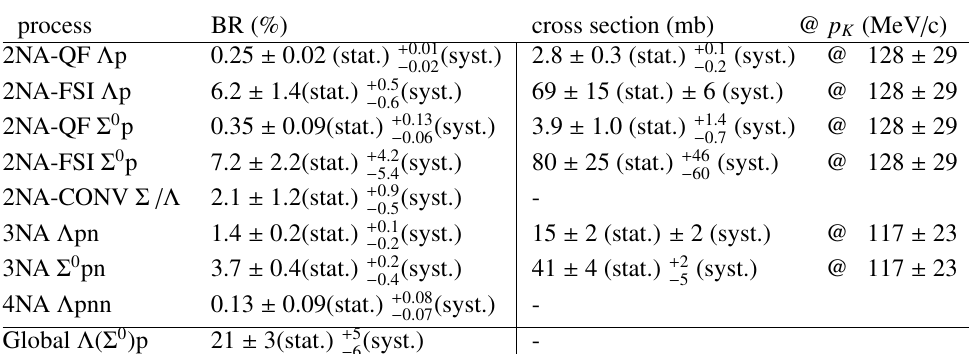
Table 1. Branching ratios (for the K − absorbed at-rest) and cross sections (for the K − absorbed in-flight) of the K − multi-nucleon absorption processes. The K − momentum is evaluated in the centre of mass reference frame of the absorbing nucleons, thus it di ff ers for the 2NA and 3NA processes. The statistical and systematic errors are also given. The Table is adapted from Ref.